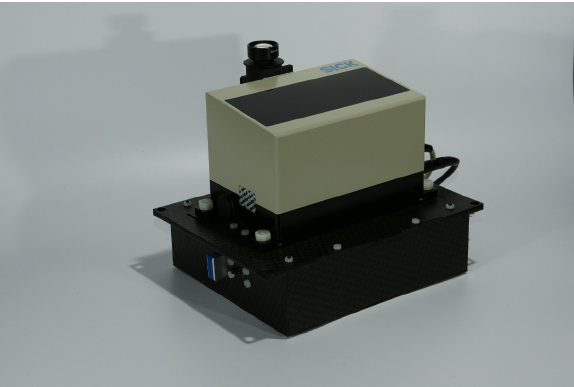
Figure 3. Sensor package with laser scanner, camera, and computing system